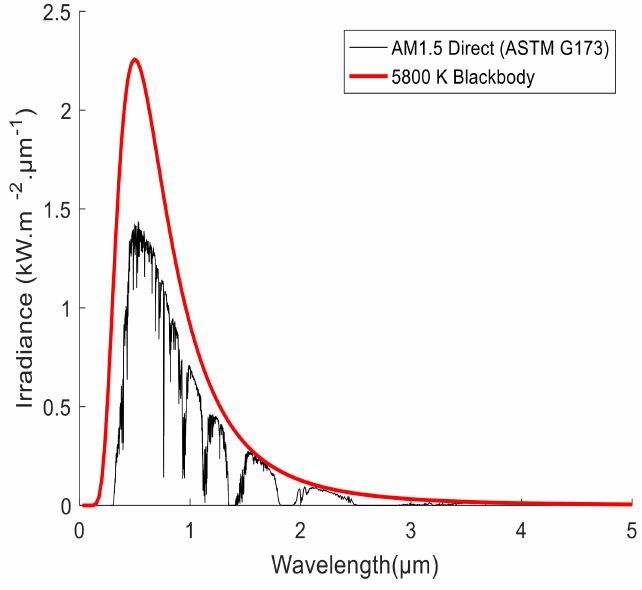
Figure 8. (ASTMG173) solar spectrum and irradiance of a blackbody at 5800 K.